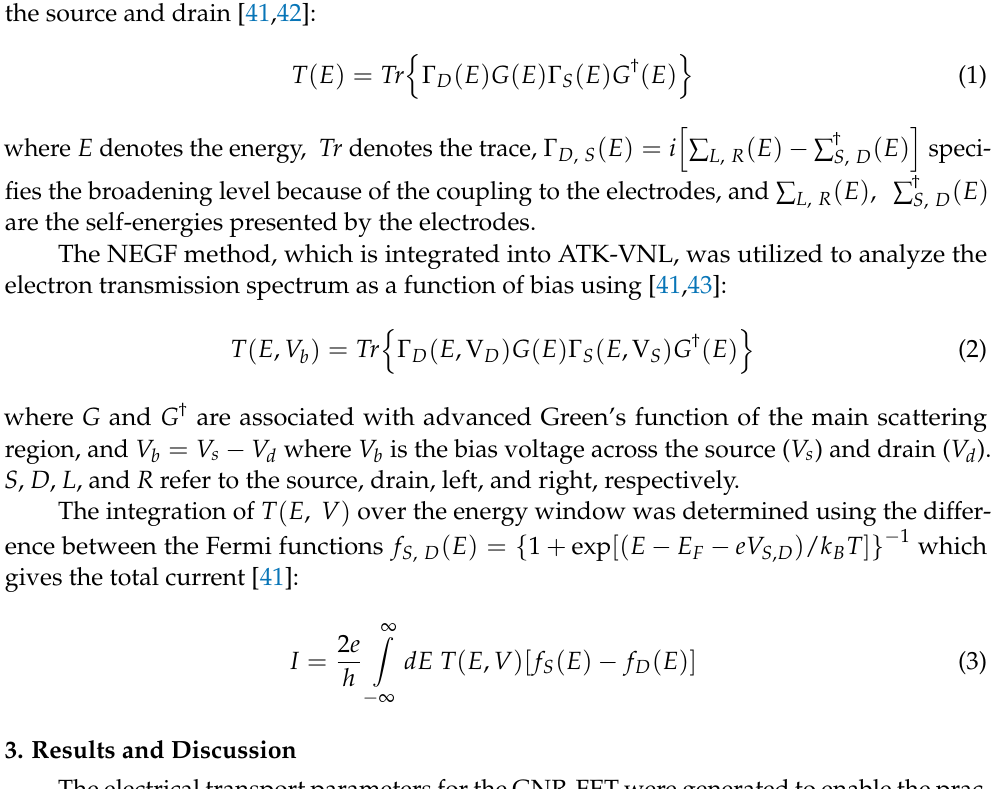
Figure 4. Cross-sectional view of the GNR-FET device with xylose. 2.3. Computational Method